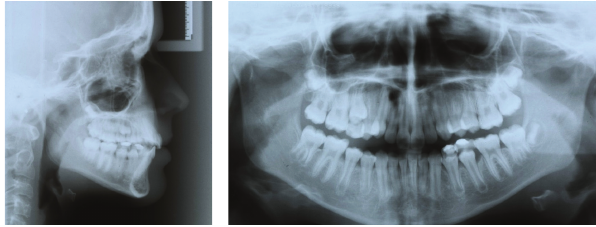
Figure 3: Pretreatment